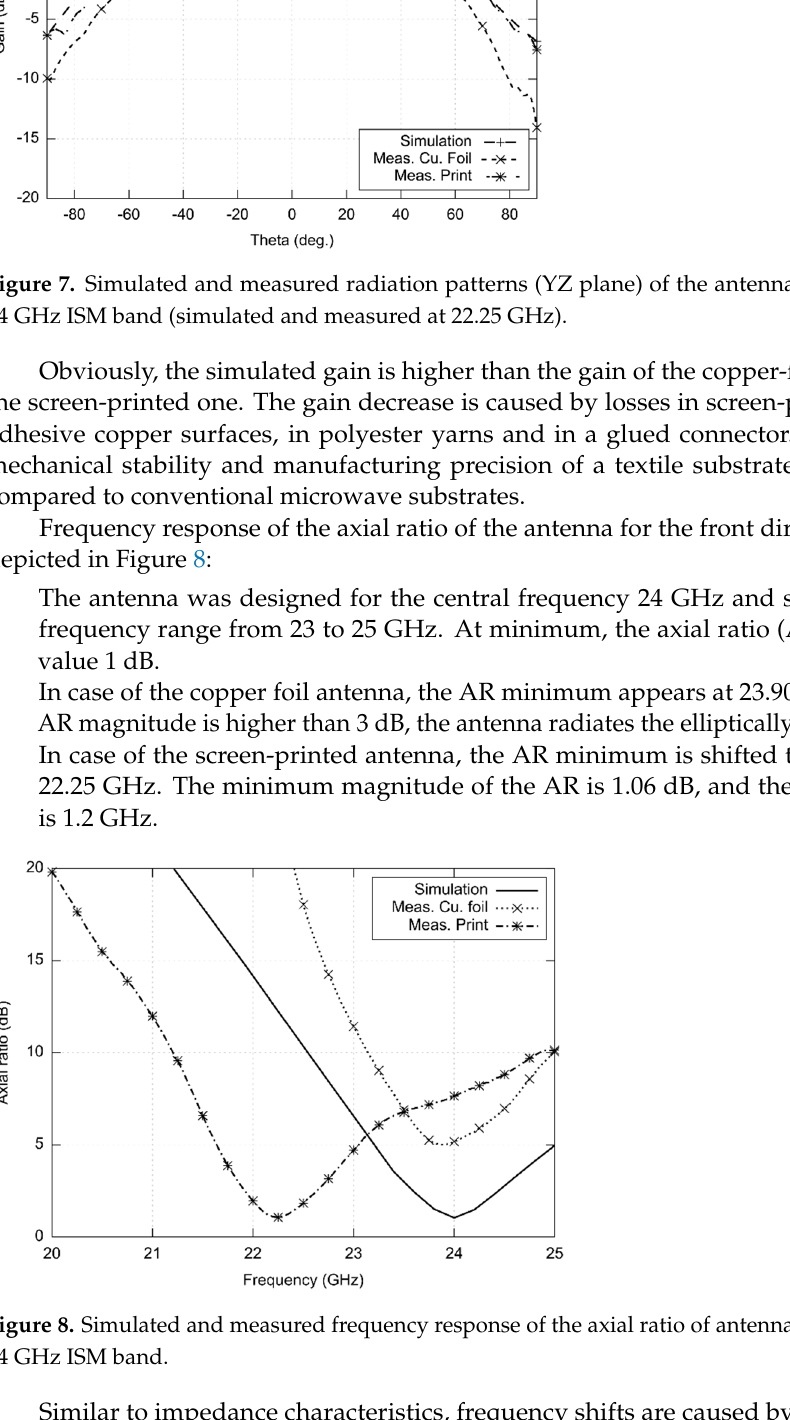
Figure 6. Simulated and measured radiation patterns (XZ plane) of the antenna designed for the 24 GHz ISM band (simulated and measured at 22.25 GHz).